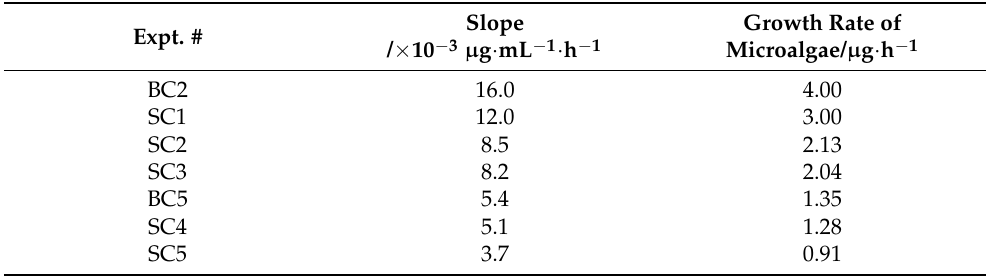
Table 3. Calculated slopes from the linear fit (Figure 3) of the calculated A. obliquus growth during precipitation of calcium carbonate in supersaturated solutions in the presence of A. obliquus culture and nutrient medium, under illumination, in the presence of zinc; 25 ◦ C, pH initial 8.50, 0.15 M of NaCl, Expt. #, total calcium.